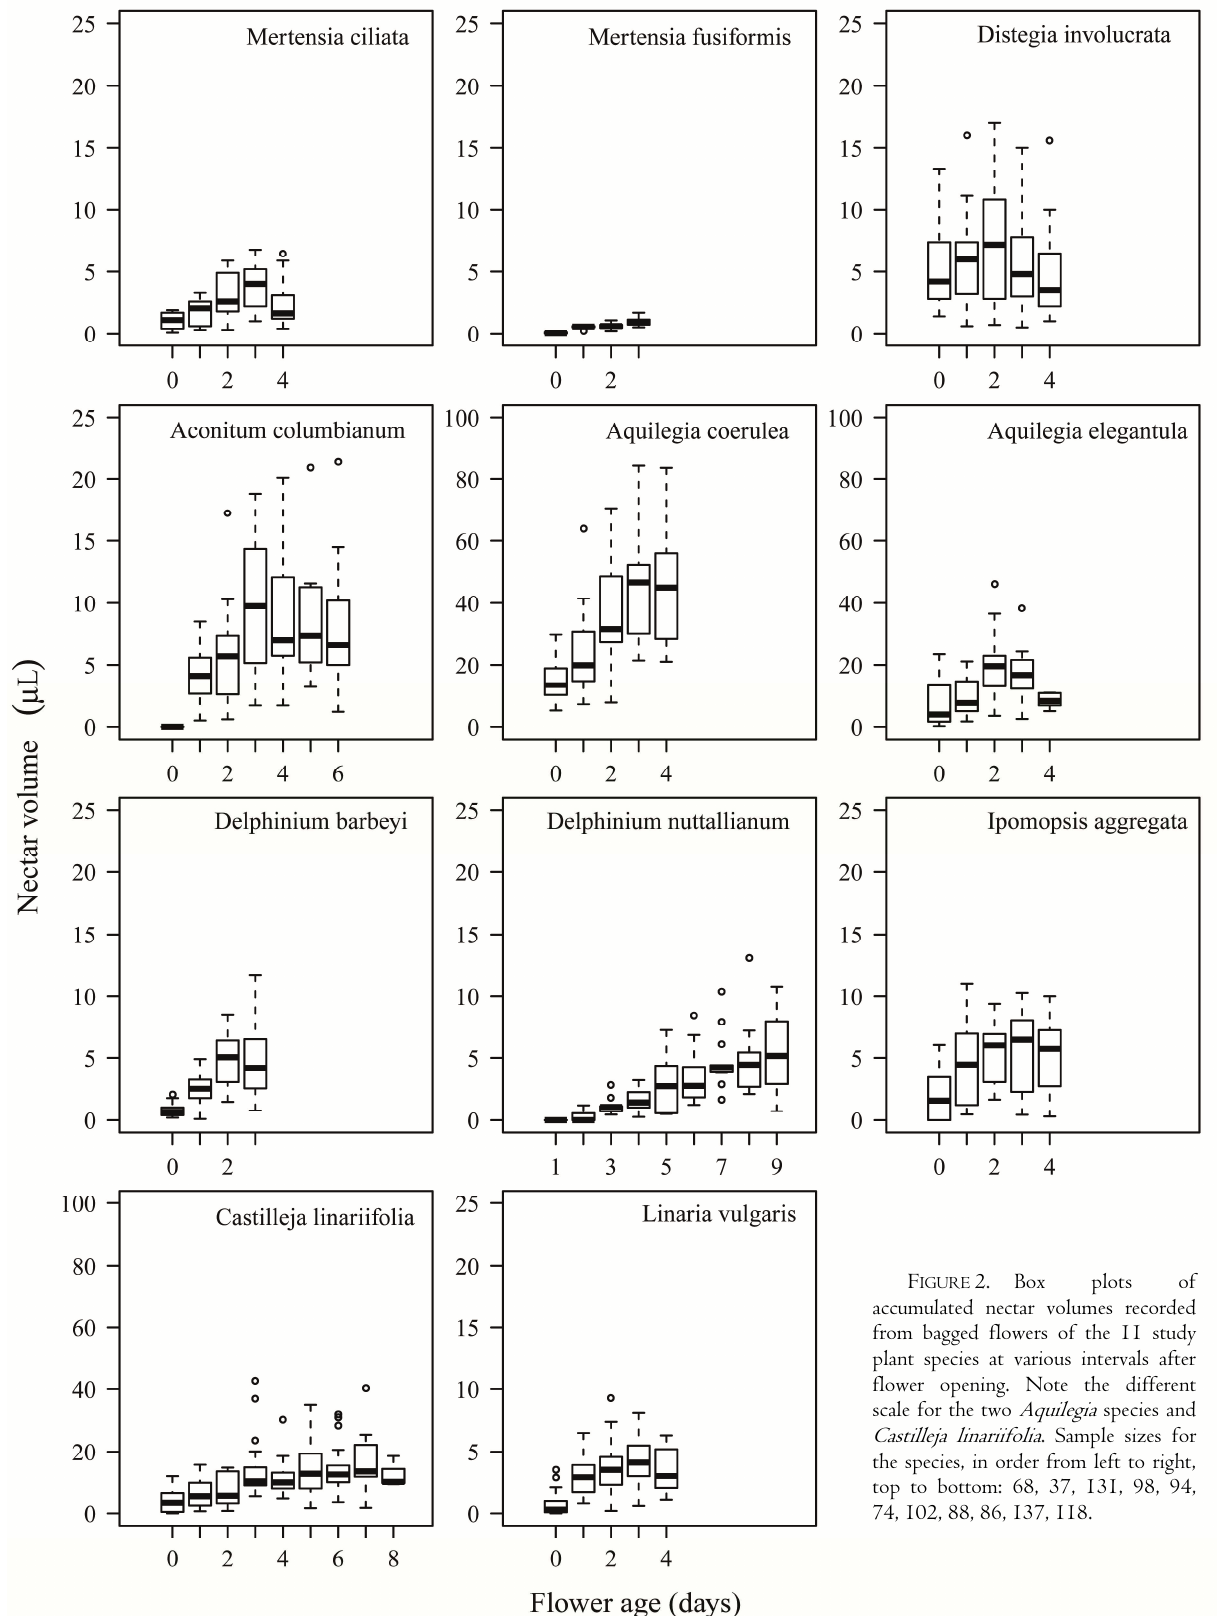
F IGURE 2. Box plots of accumulated nectar volumes recorded from bagged flowers of the 11 study plant species at various intervals after flower opening. Note the different scale for the two Aquilegia species and Castilleja linariifolia . Sample sizes for the species, in order from left to right, top to bottom: 68, 37, 131, 98, 94, 74, 102, 88, 86, 137,